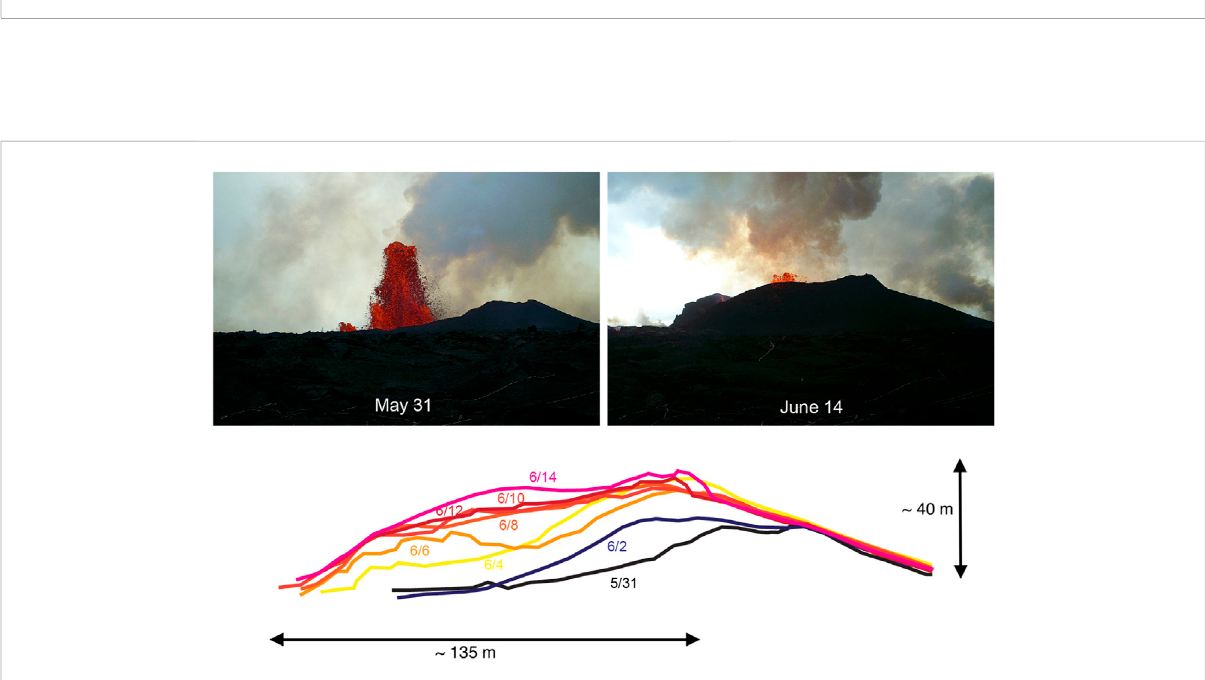
FIGURE 3 Sketch of cone pro fi les throughout the fi rst half of June, derived from video frames. The top two fi gures show the camera view on May 31 and June 14 as an example of the cone growth. The location of the camera is shown in Figure 1A. The bottom sketch shows the outline of the cone as seen from the orientation of the camera for the days in between. Each line is annotated by its date. The scale bars correspond to the